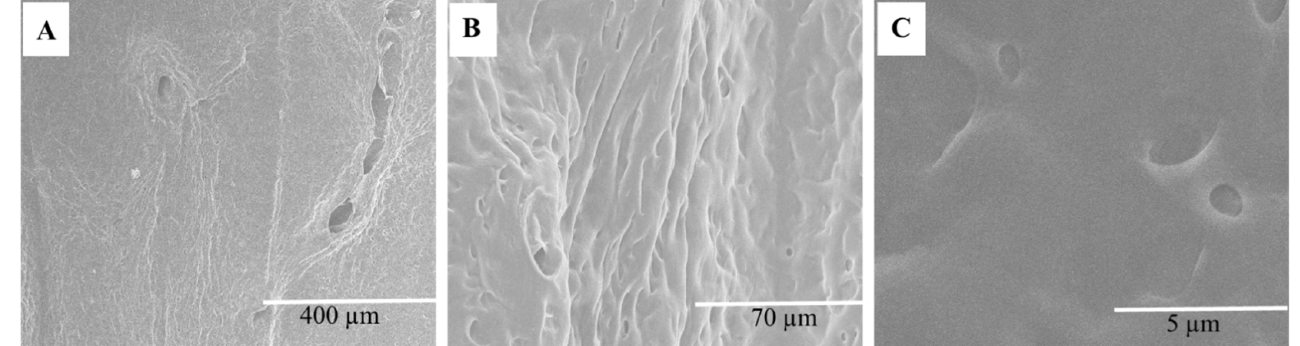
Figure 2. Panels showing the SEM images of decellularized avian articular cartilage. ( A ) Scale bar = 400 µm. ( B ) Scale bar = 70 µm. ( C ) Scale bar = 5 µm.